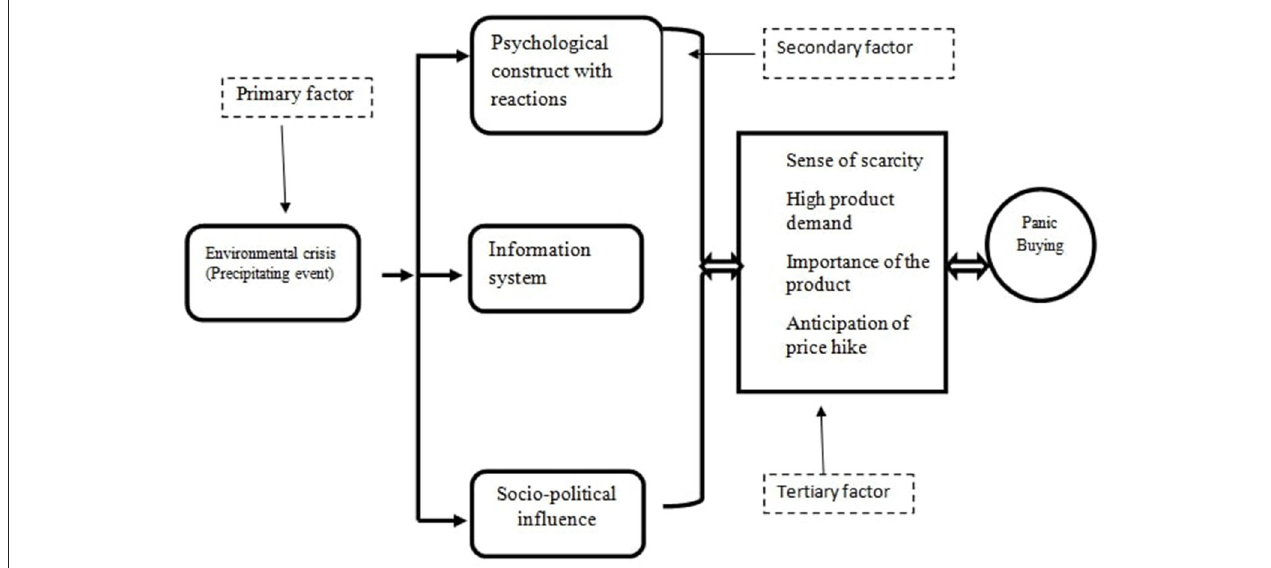
FIGURE 1 | Environmental stimuli and human psychology interaction model [Adapted from (Arafat et